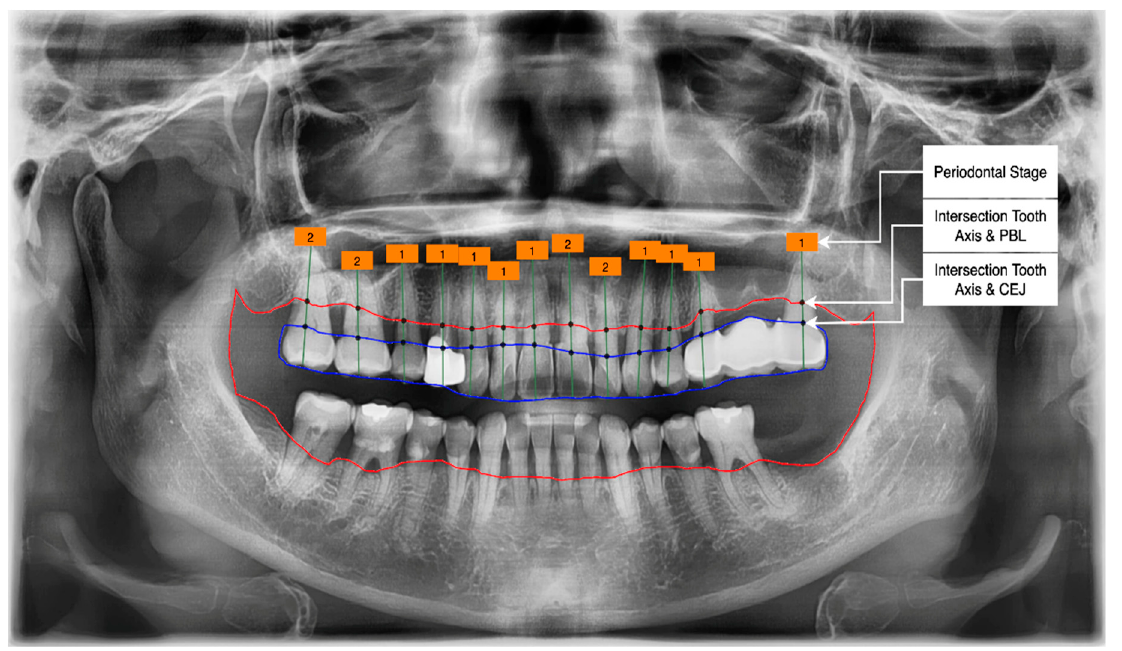
Figure 11. Periodontal stage classification according to the RBL ratio using the PBL and CEJ length intersection.